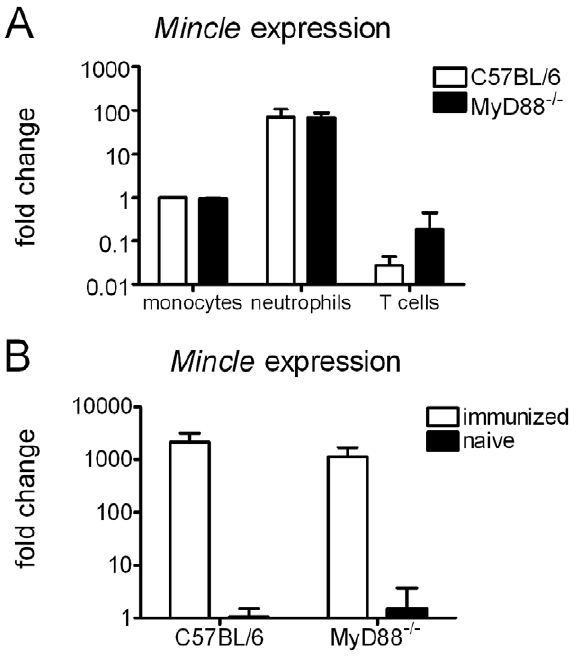
Figure 2. Basal and DDA/TDB-induced Mincle expression is not reduced in the absence of MyD88. Mincle expression determined by qRT-PCR in sorted cells from naive C57BL/6 or MyD88 2 / 2 mice ( A ). Fold change calculated against sorted monocytes from C57BL/6 mice. Data presented as mean 6 SD pooled from 2 independent sorts. Mincle expression determined by qRT-PCR in vaccinated and naı¨ve mice ( B ). RNA isolated from footpads 3 days post immunization. Fold change calculated against naive C57BL/6. Data presented as mean 6 SD pooled from 2 independent experiments with 2–3 mice/group.